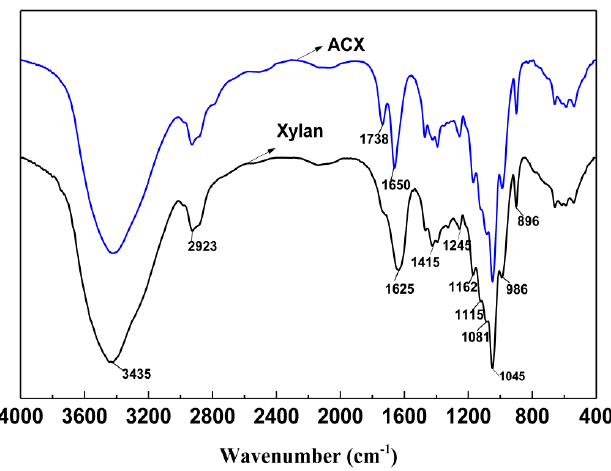
Figure 1. FTIR spectra of xylan and ACX.